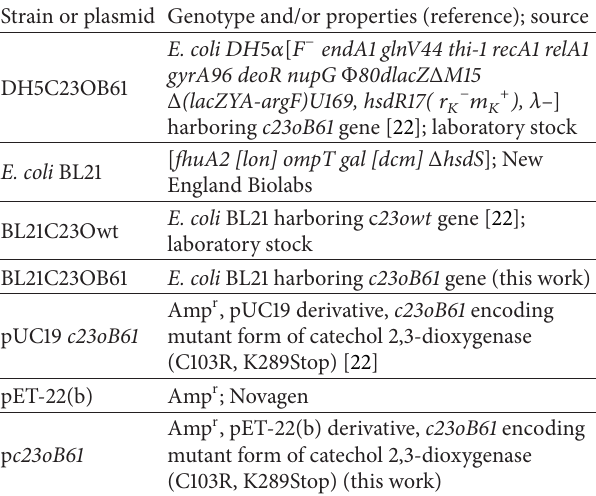
Table 1: Strains and